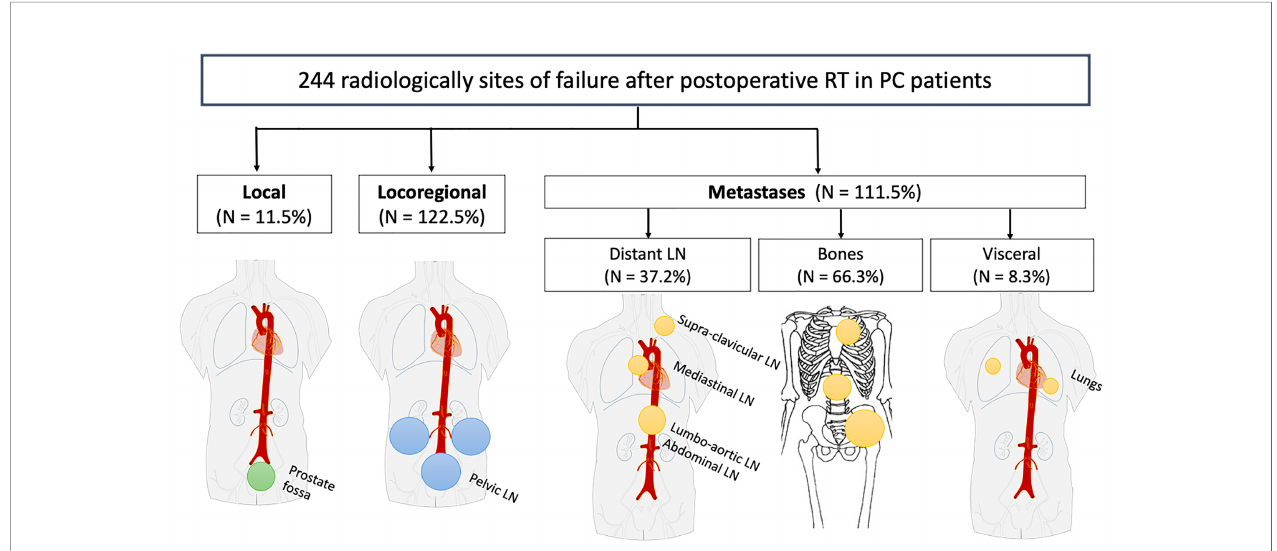
FIGURE 3 | Diagram depicting anatomical sites of recurrence for the 244 radiologically sites of failure after postoperative RT in PC patients. LN, Lymph Nodes; PC, Prostate Cancer; RT, radiotherapy.